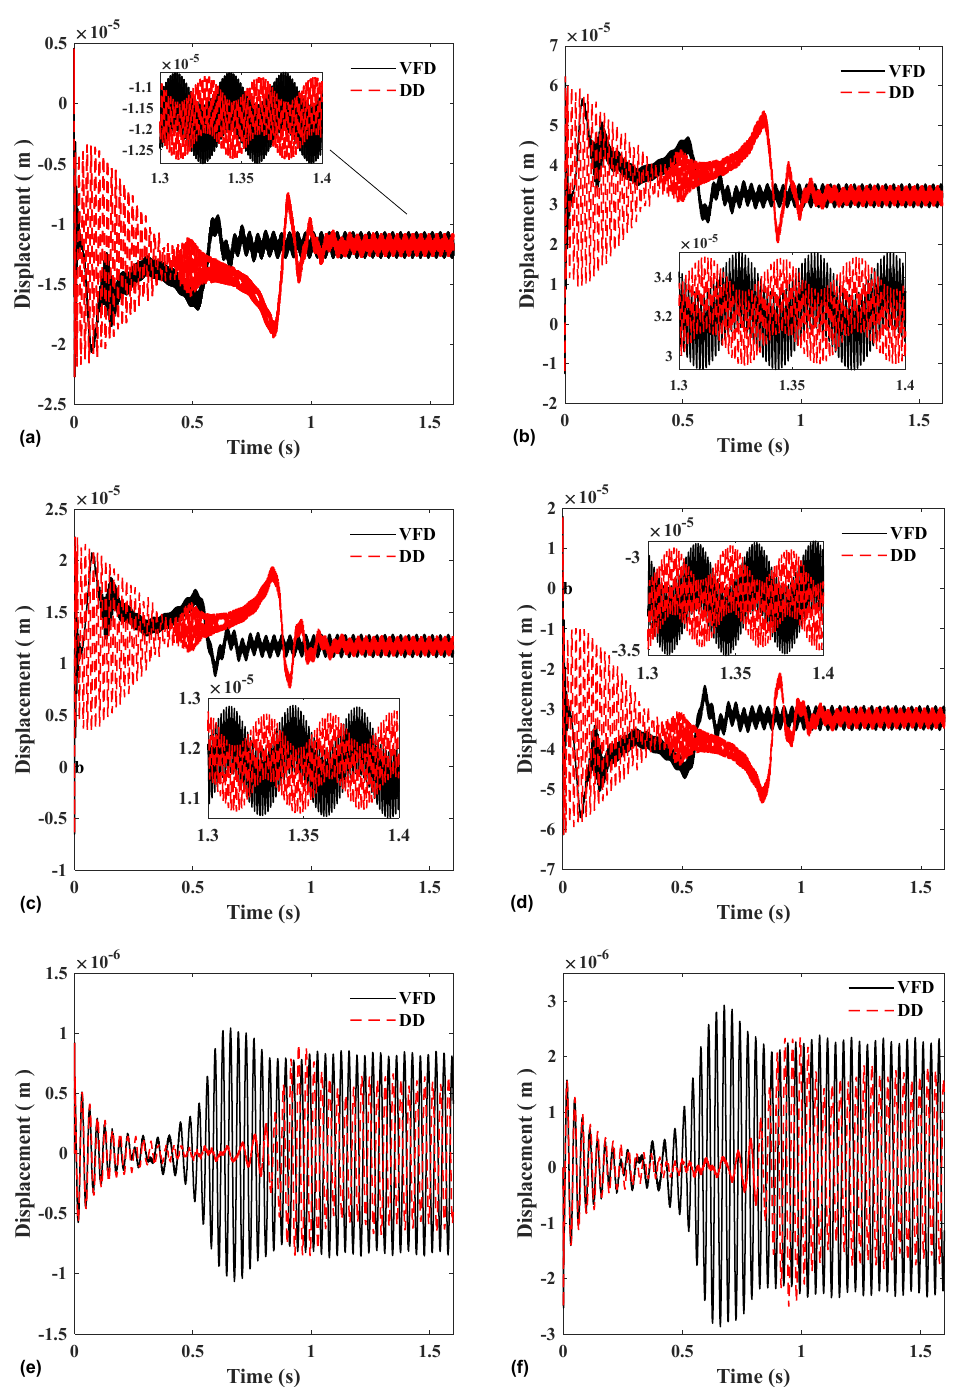
Figure 16. ( a ) Gear 1 X − direction; ( b ) Gear 1 Y − direction; ( c ) Gear 2 X − direction; ( d ) Gear 2 Y − direction; (e) Gear 3 X − direction; and ( f ) Gear 3 Y − direction.